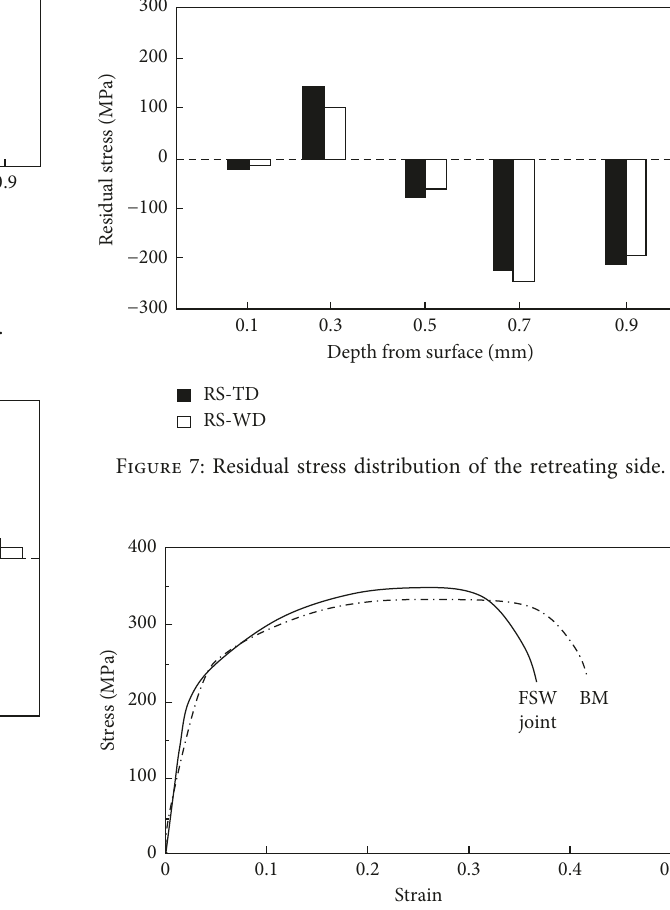
Figure 8: Stress-strain curves of the BM and FSW